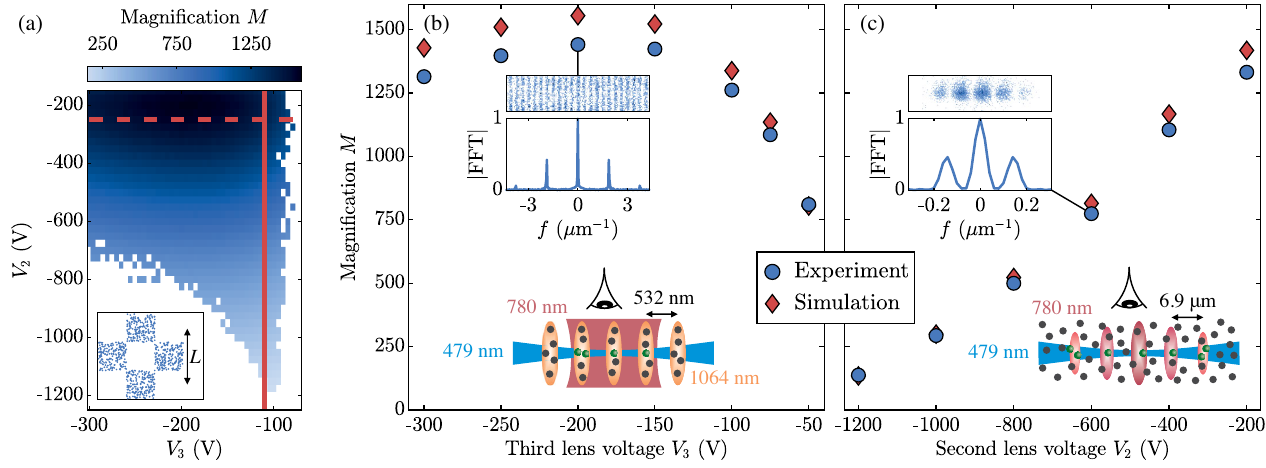
¼ − V ¼ − 500 V, V ¼ − 3 . 2 kV, 1 E R